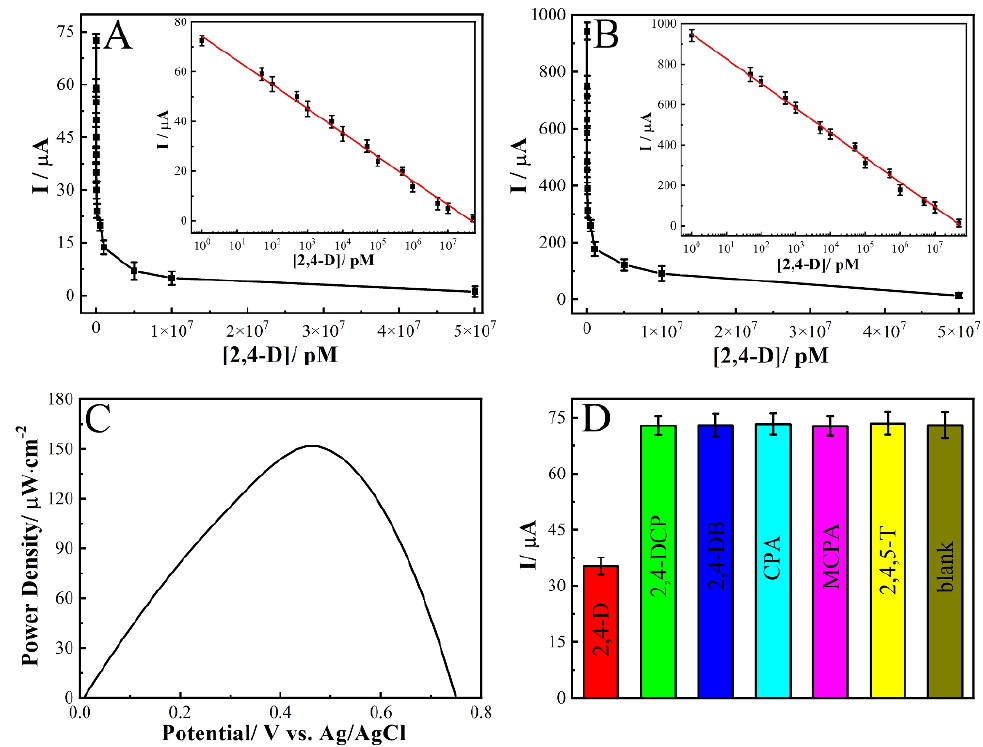
Figure 4. The relationship between the current response and 2,4-D concentration without ( A ) and with ( B ) PS amplification; ( C ) dependence of the power density on the cell voltage in 0.10 M air-saturated PBS with 30 mM glucose; ( D ) selectivity investigation of the proposed method.